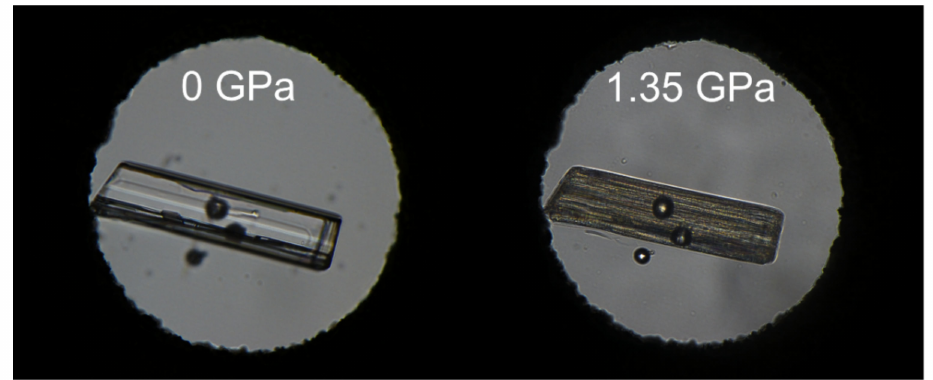
Figure 7. Photographs showing LLHM crystal destruction in PIP at pressure 1.35 GPa. LLHM crystal at 0 GPa ( left ) and 1.35 GPa ( right ). Crystal size is 0.3 mm × 0.05 mm × 0.02